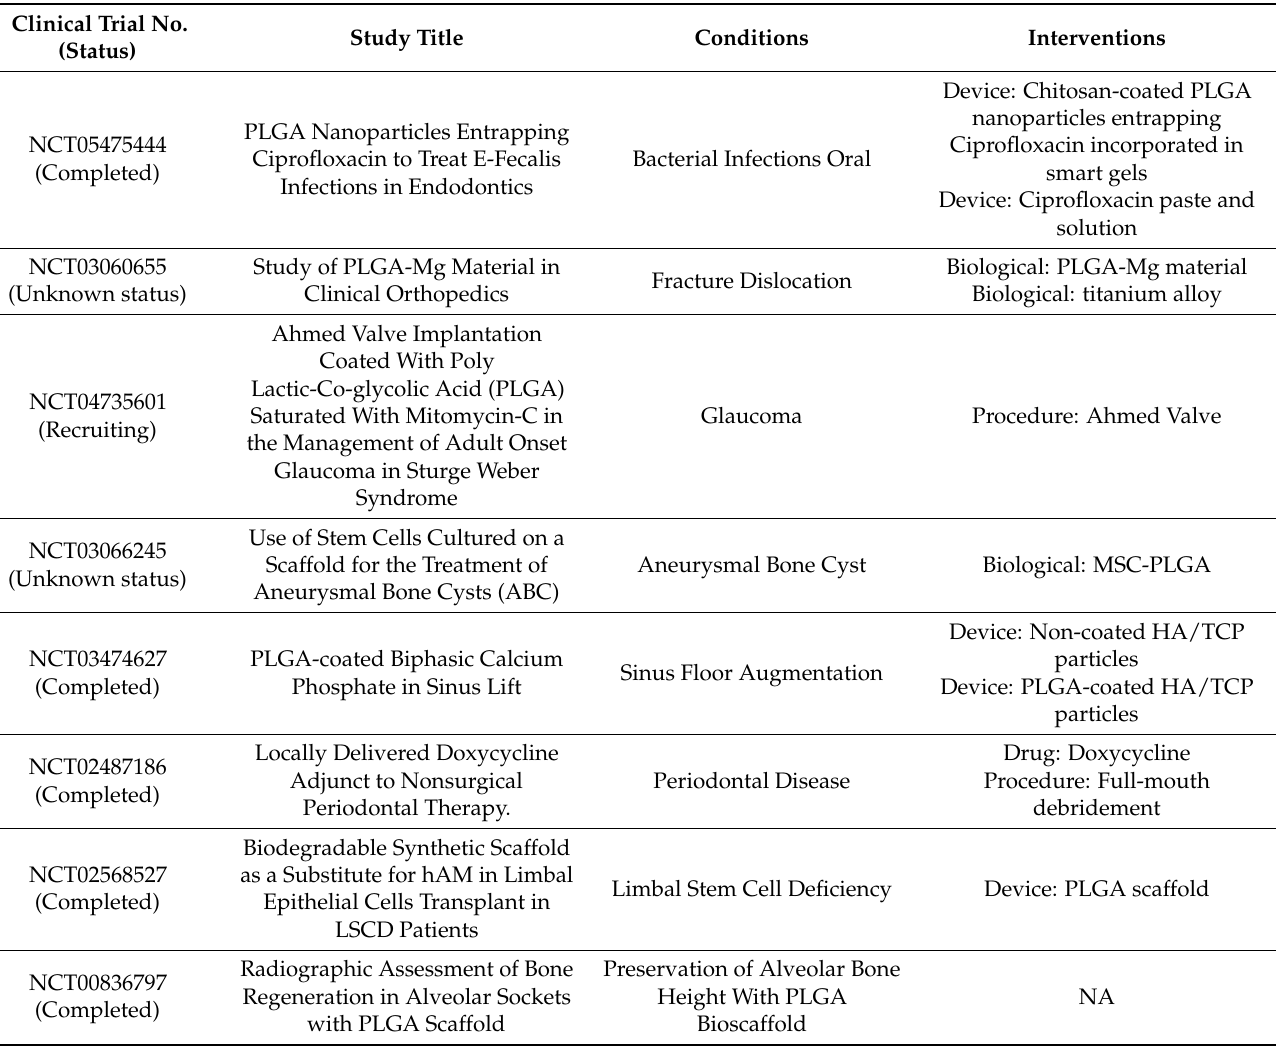
Table 4. Current clinical trials enlisted in clinicaltrials.gov website. ClinicalTrials.gov search